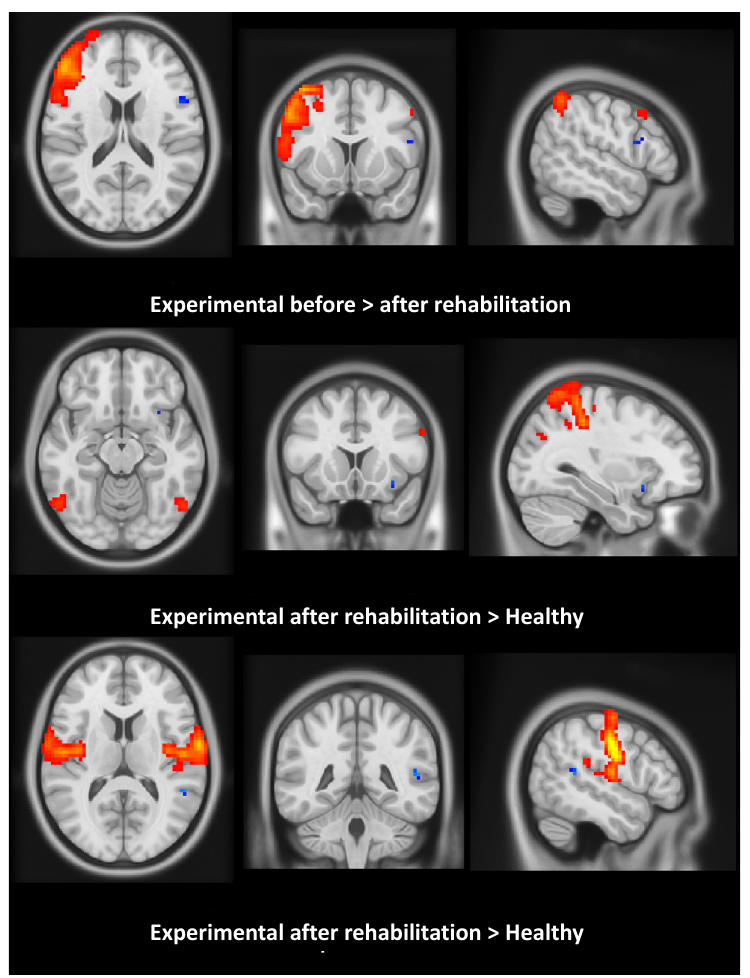
Figure 2. rsMRI processing. Results refer to patients in the experimental group, and to the condition “before” vs. “after” rehabilitation. Red areas correspond to the selected network activation, while blue voxels represent significantly different clusters of activity. In the sensory-motor network, involvement of the left insula and left superior temporal cortex was evident when comparing the experimental after rehabilitation versus the healthy group. In the right fronto-parietal network, we found involvement of the left frontal inferior cortex when comparing the experimental group before and after rehabilitation.